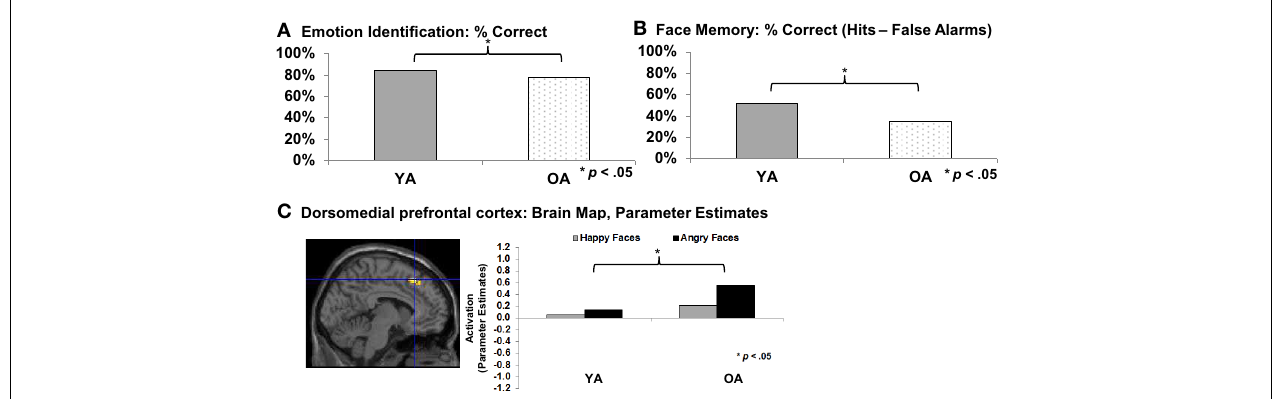
FIGURE 1 | (A) Emotion identification (Ebner et al., 2010); (B) Face memory (Ebner and Johnson, 2009); (C) Emotion identification: dorsomedial prefrontal cortex (Ebner et al., 2012). YA, Young adults; OA, Older